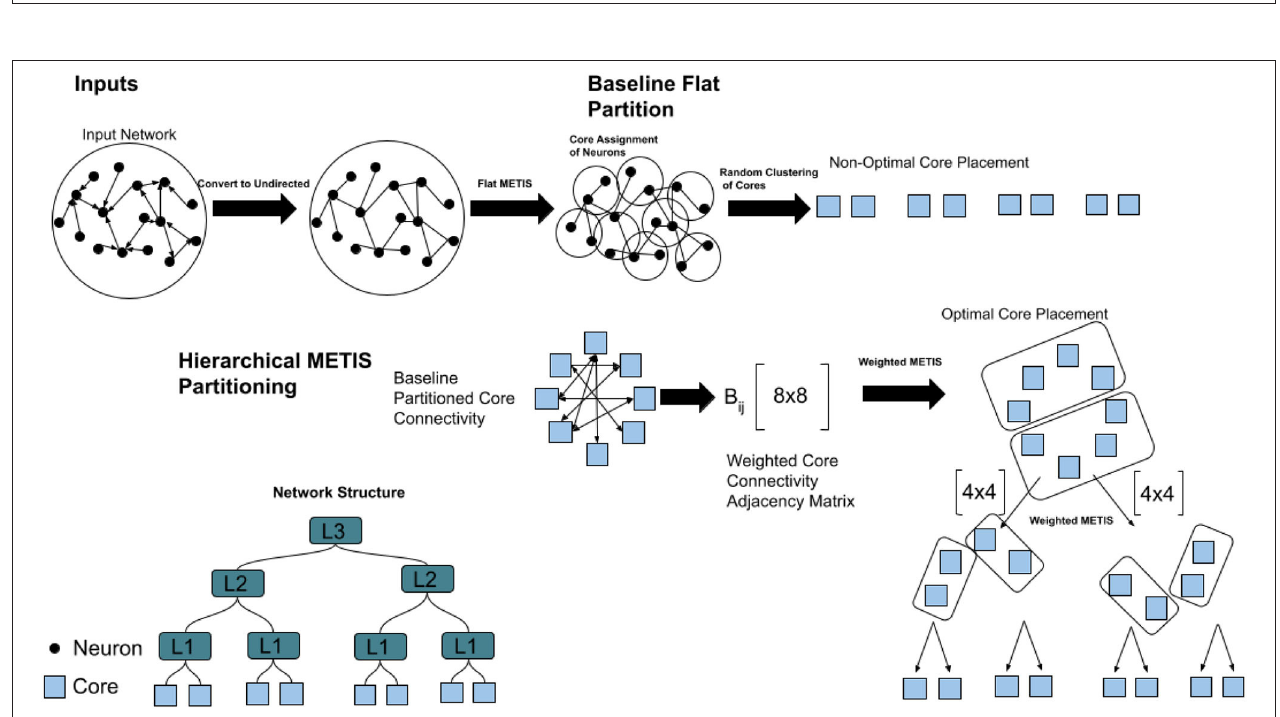
FIGURE 2 | Unicast vs. Multicast communication. The red arrows describe communication within a cluster ( L 1 communication) and the green arrows describe communication between the clusters ( L 2 communication). In the unicast example, each postsynaptic destination core address is explicitly defined in the communication packet (e.g., [1,1] and [2,5]), and each crossing of hierarchy requires an explicit message. In the multicast example, only the destination mask is defined in the communication packet. In both multi-level cases, “relay” connections are needed in order to route to the destination core, which routes to the correct core at the local level of hierarchy. In the unicast case, a single relay connection is needed over L 2 to core [1,1] and two relay connections are required in this local L 1 to route to cores [3] and [6]. In the multicast case, a single relay connection is needed over L 2 and additionally over each L 1 .